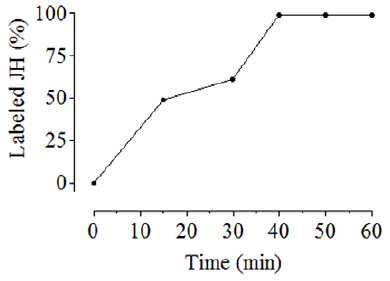
Figure 4. The efficiency of derivatization of the JH III epoxide ring with DBD-COCl. Fluorescence signal increases with time of incubation up to 40 minutes. Each point represents the percentage of tagged JH III peak area measured by HPLC-FD. Data represent the means 6 SD of three independent experiments.